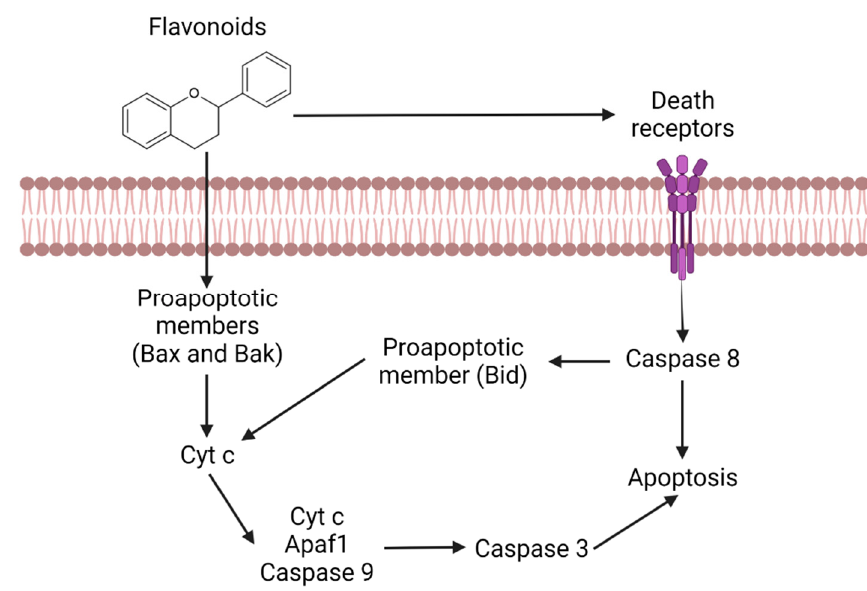
Figure 3. Scheme illustrating the flavonoid action on the reactive oxygen species (ROS) pathway. The apoptosis induction is another of the main mechanisms of action, being responsible for the activation of death receptors as well as the activation of Bax and Bak proapoptotic members (Figure 4) [17]. Bax, Bak and Bid are apoptosis regulator proteins that have